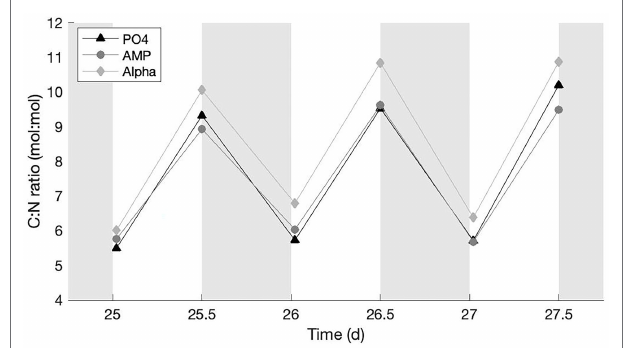
FIGURE 2 | C:N ratios in cultures provided with either an inorganic (PO 4 ; triangles) or organic [mono phosphate adenosin (AMP; circles) or DL- α - glycerophosphate (Alpha; diamonds)] source of phosphorus for growth. The grey, shaded area represents the dark phase.